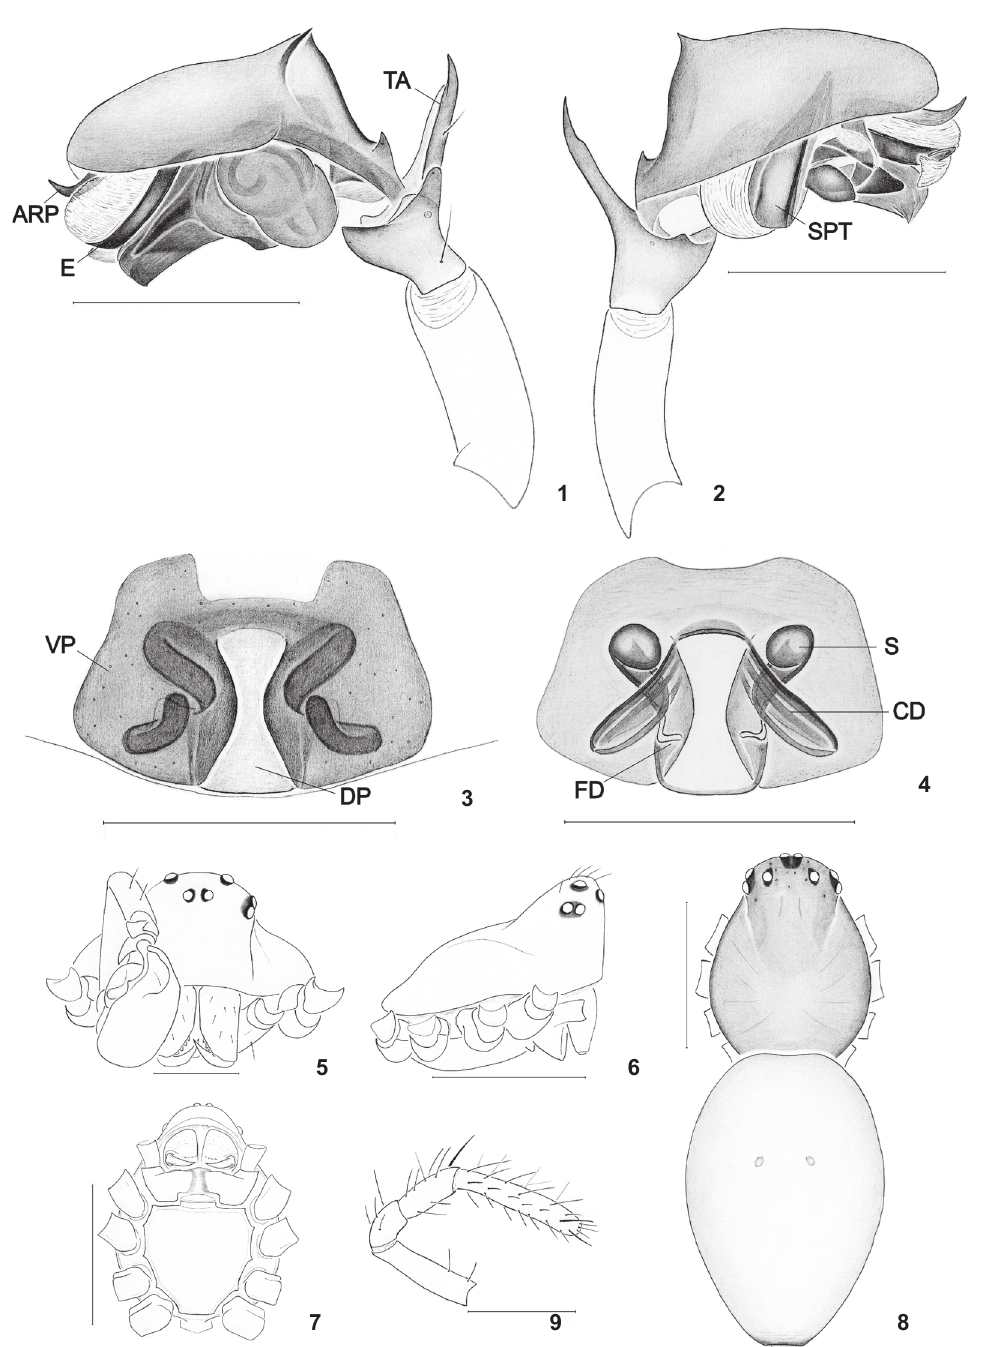
Figures 1-9. Psilocymbium antonina sp. nov. (1-2) Male palpus: (1) ectal view; (2) mesal view. (3-4) Female epygine: (3) ventral view, (4) dorsal view, cleared. (5-8) Male habitus: (5) frontal view of carapace; (6) lateral view; (7) ventral view, sternum detail; (8) habitus, dorsal view. (9) Female palp. (ARP) Anterior radical process, (CD) copulatory duct, (DP) dorsal plate, (DT) distal tooth of tibial apophysis, (E) embolus, (FD) fertilization duct, (TA) tibial apophysis, (S) spermatheca, (SPT) suprategulum, (ST) subtegulum, (T) tegulum, (VP) ventral plate. Scale bars: (1-4 and 9) 0,25 mm, (5-8) 0,5